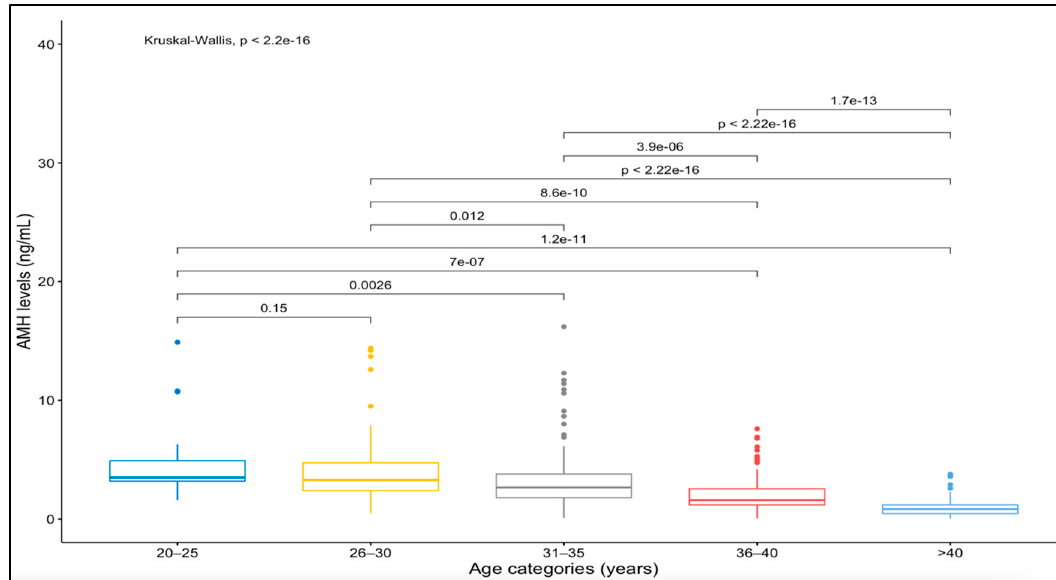
Figure 4. AMH levels versus age categories of women treated for infertility.